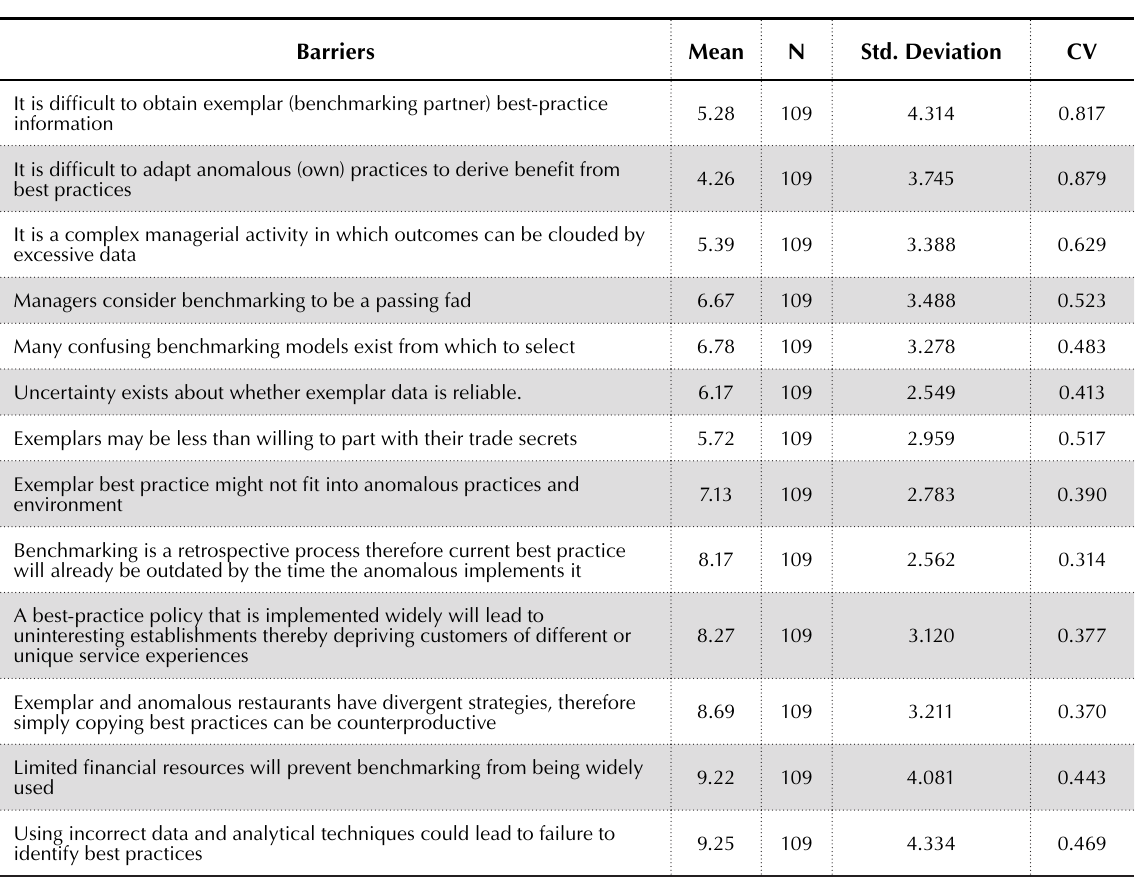
Table 3. Barriers’ standard